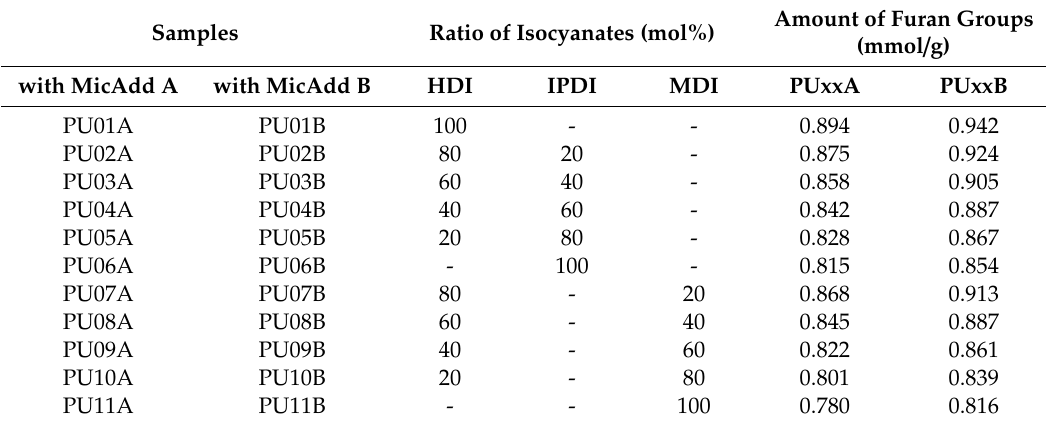
Table 1. Isocyanate composition of linear